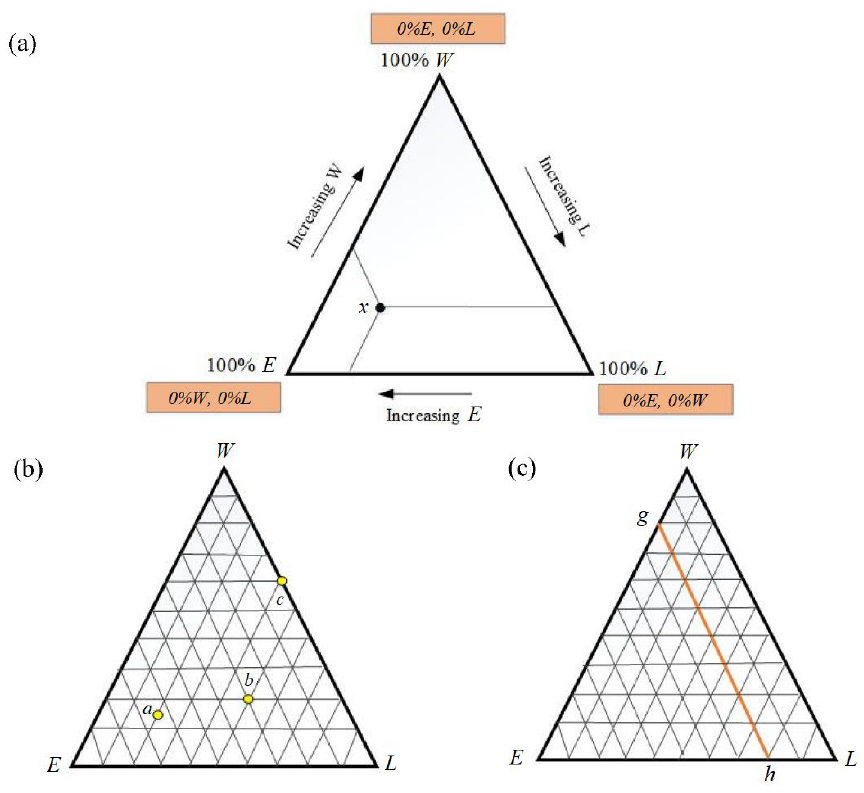
Figure 1. Representation of ternary diagram. ( a ) three-resource system, ( b ) the composition at different points, ( c ) line parallel to any side of the triangle.